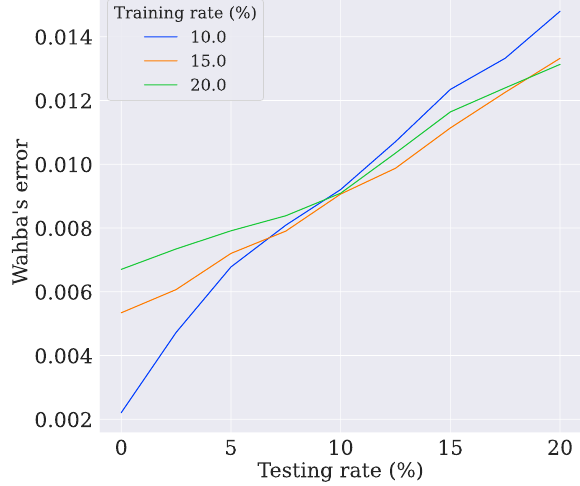
Figure 10. The evolution of Wahba’s error for test case 8.